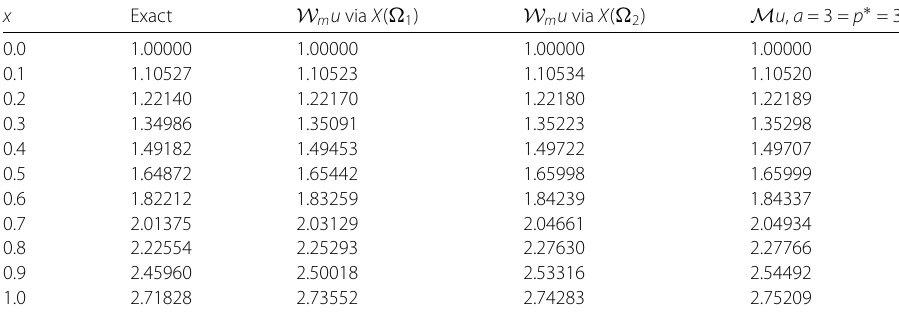
Table 2 Numerical results of Example 4.1 using the framelet systems X ( (cid:7) 1 ) and X ( (cid:7) 2 ) for m = 3 and λ = 3.5